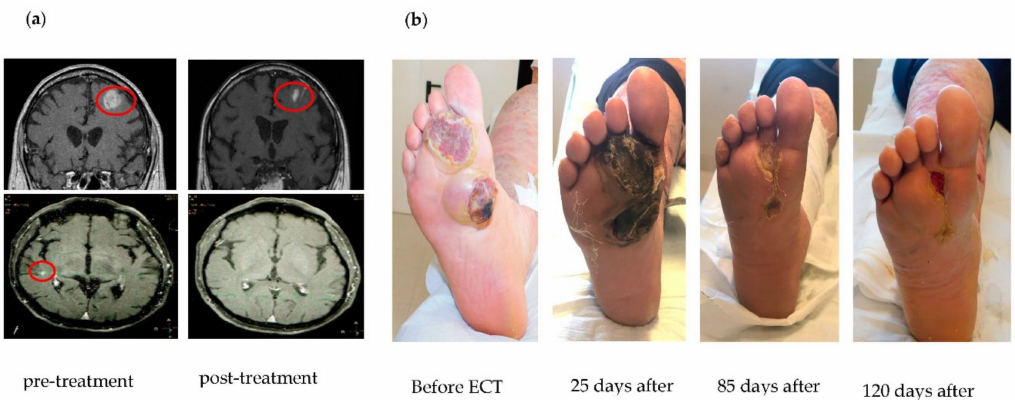
Figure 2. Representative cases of patients treated with di ff erent loco-regional treatments on oligoprogression sites while continuing systemic treatments: ( a ) Patient treated with strereotactic surgery on brain metastases and anti-BRAF plus anti-MEK systemic therapy; ( b ) patient treated with local electrochemotherapy and systemic anti-PD-1